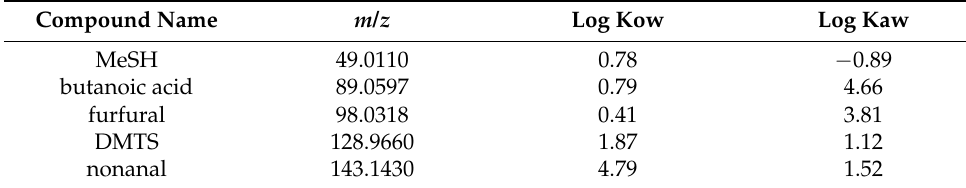
Table 1. The studied aroma compounds PTR-MS m / z , Log Kow, and Log Kaw values. The value of Log Kow and Log Kaw are calculated by EPI suite (https://www.epa.gov/tsca-screening-tools/epi-